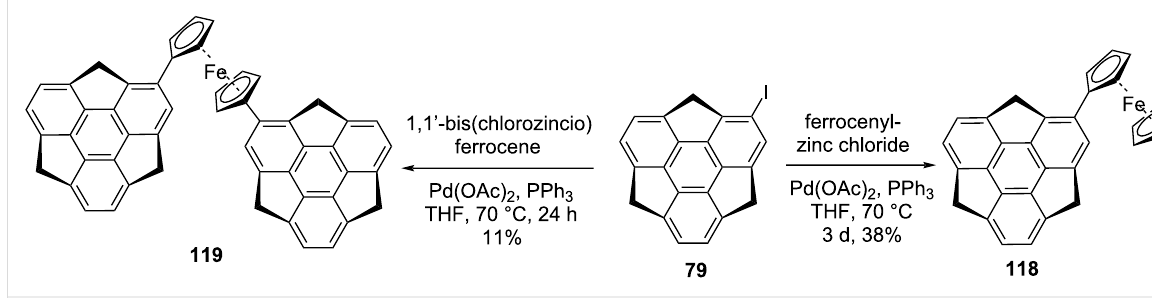
Scheme 28: Synthesis of sumanenylferrocene architectures 118 and 119 via Negishi coupling.